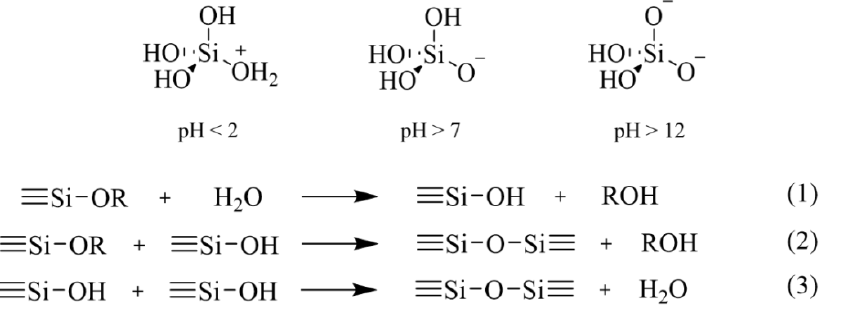
Figure 8. Protonation/deprotonation of orthosilicic acid. Hydrolysis and condensation reactions of silica precursors.